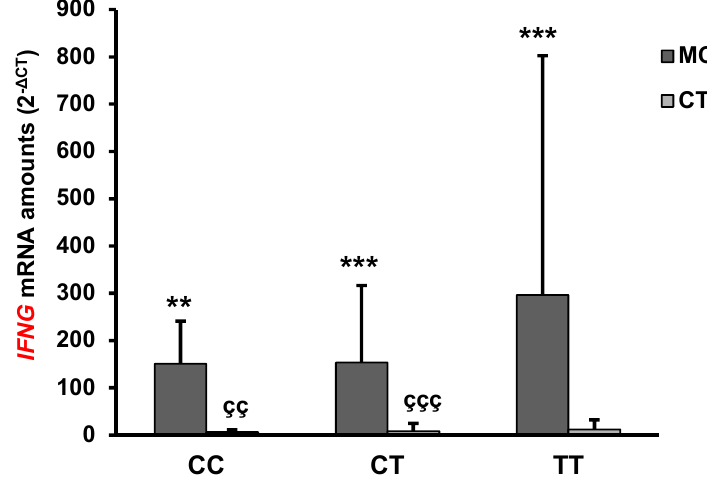
Figure 2. Mean IFNG mRNA expression levels in PBMC of MCS patients and healthy subjects (CTR) having different ADORA2A rs2298383 genotypes. Values shown are expressed as means ± SD. ** p < 0.01, *** p < 0.001, significant difference in comparison with CTR having same genotype; çç p < 0.01, ççç p < 0.001, significant difference in comparison with TT MCS.